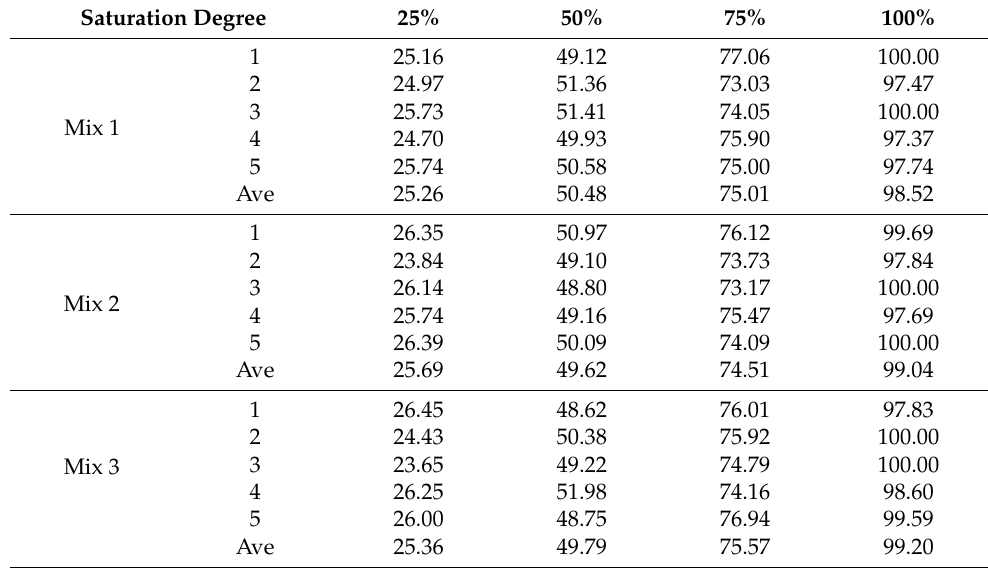
Table 4. Measured saturation levels of concrete cylinders in this study.